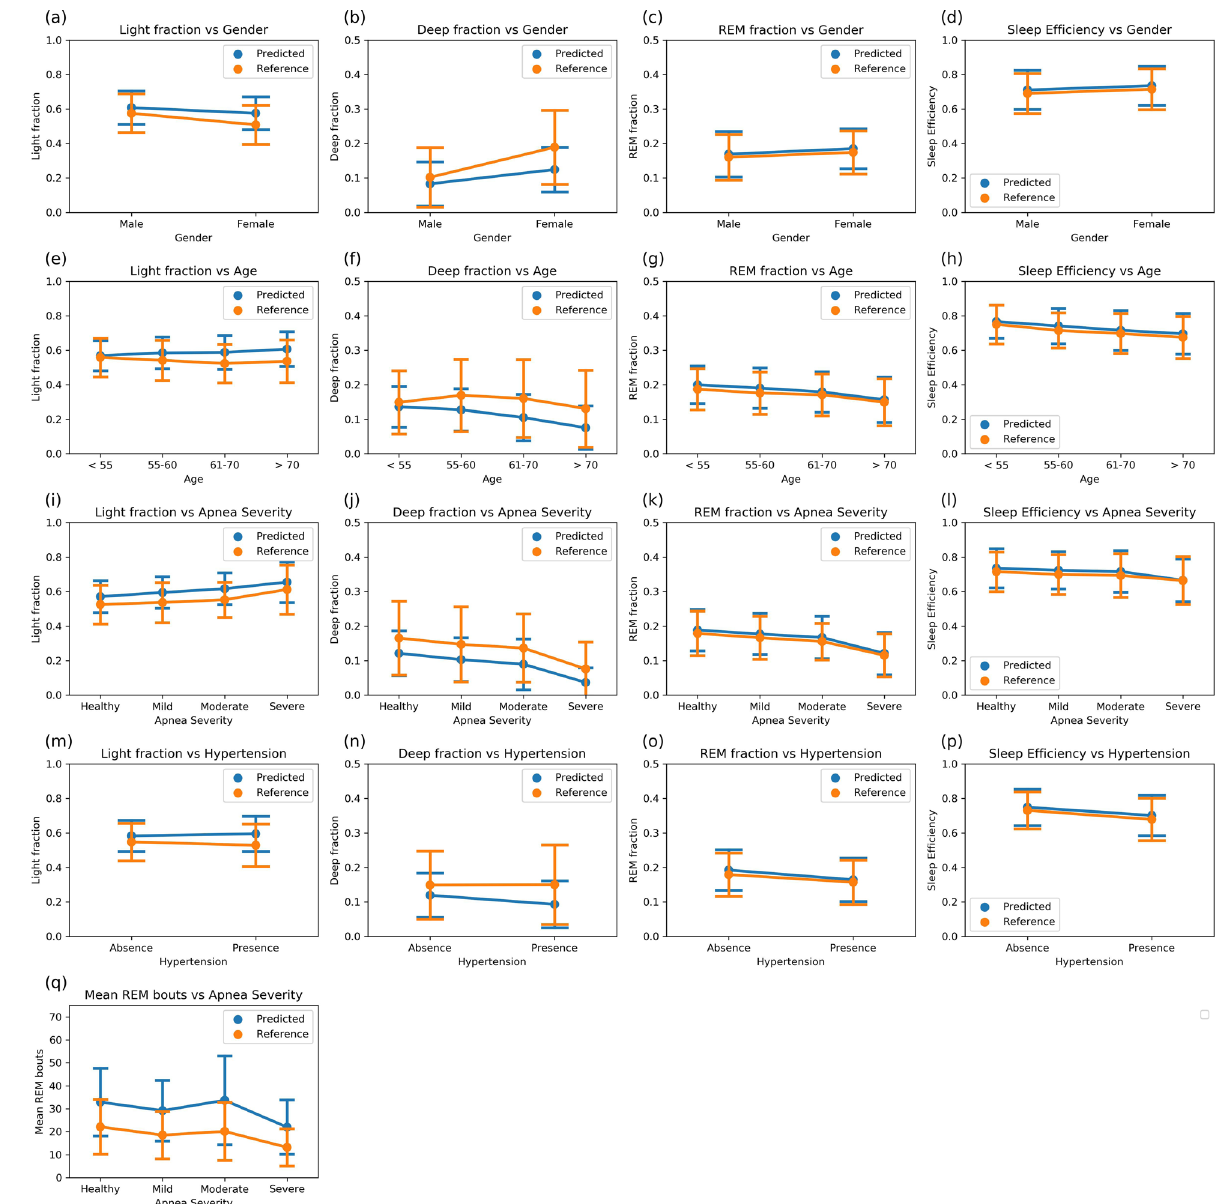
Fig. 5 Distributions of sleep metrics derived from PSG reference and model predicted stages. The test population is split into groups by the clinical measures marked in the x -axis. The y -axis shows the values of sleep metrics — points represent the mean value of the metrics and the bars represent the standard deviations. The distributions calculated using the PSG reference stages and the algorithmically predicted stages show excellent concordance for fraction of REM during sleep and sleep ef fi ciency. Deep sleep is underestimated by our model in favor of light sleep, yet the qualitative effect of clinical states on light and deep fractions is consistent between reference and predicted stages. a – d stage fractions and sleep ef fi ciency with gender. N = 360, 440. e – h stage fractions and sleep ef fi ciency with age. N = 164, 168, 198, 270. i – l stage fractions and sleep ef fi ciency with apnea severity. N = 364, 314, 65, 57. m – p stage fractions and sleep ef fi ciency with presence of hypertension. N = 436, 364. q mean REM bout lengths with apnea severity. The mean REM bout durations calculated from algorithmically predicted stages are higher than the PSG reference stages because the predicted stages are “ smoother ” , i.e., contain fewer stage bouts that last only 1 or 2 epochs interrupting larger stage bouts. Despite this effect, the increase in REM instability seen in apneic subjects is evident. N = 364, 314, 65,